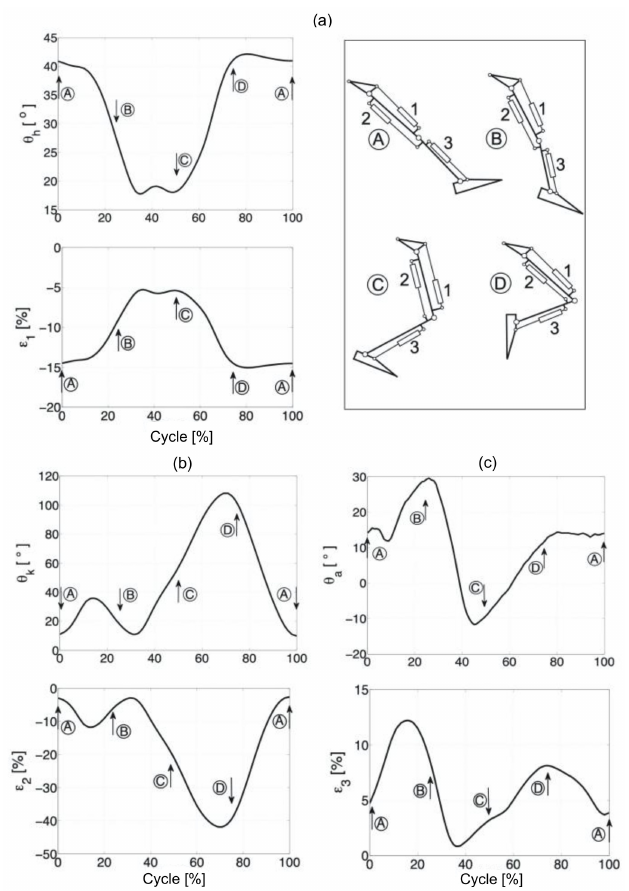
Figure 6. The angles in the joints and length of the hydraulic exoskeleton actuators, while running: Hip joint ( a ), knee joint ( b ), and ankle joint ( c ). A, B, C and D-exoskeleton positions presented on the top right